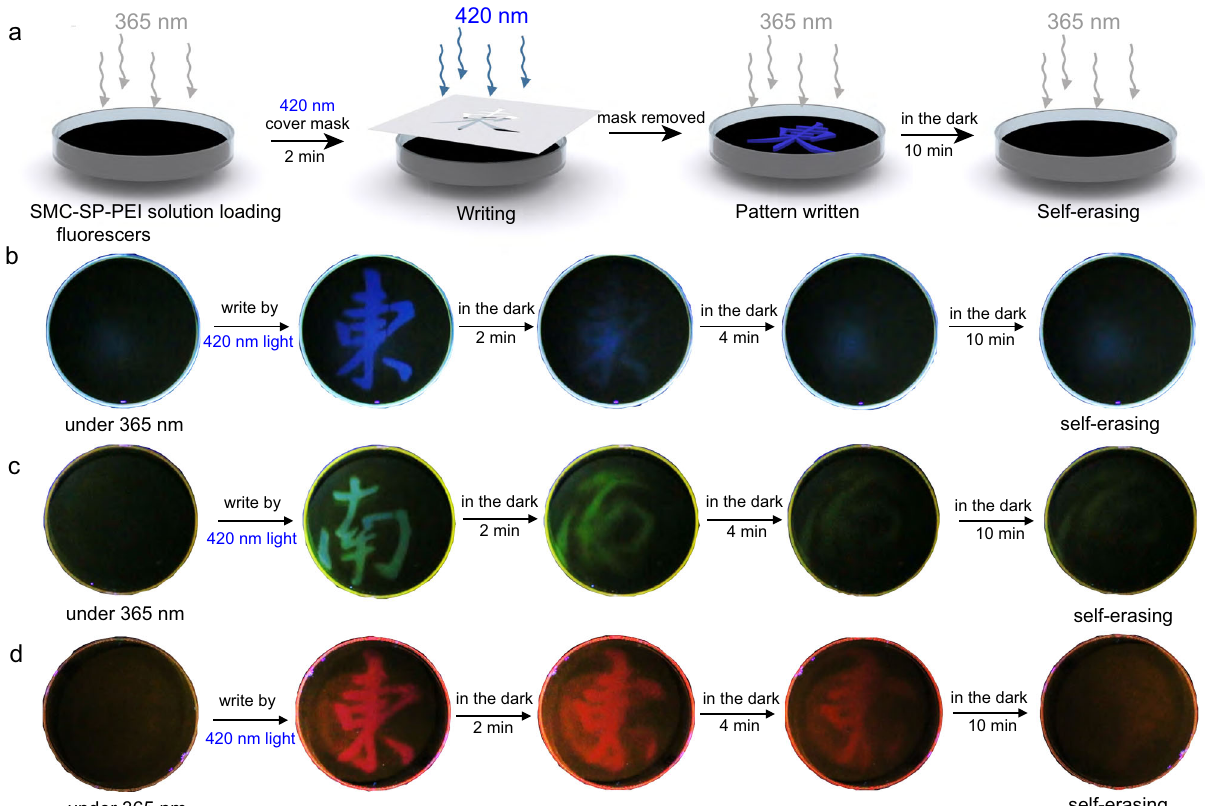
Fig. 8 Metastable fl uorescent palette for exhibiting self-erasing fl uorescent patterns in petri dish. a Schematic representation of the 420 nm light writing and 365 nm emitting the patterns in the petri dish. b Photo-writing pattern and self-erasing process of the scoparone-loaded DSAs. c Photo-writing pattern and self-erasing process of the CFDA-loaded DSAs. d Photo-writing pattern and self-erasing process of the Rh101-loaded DSAs.